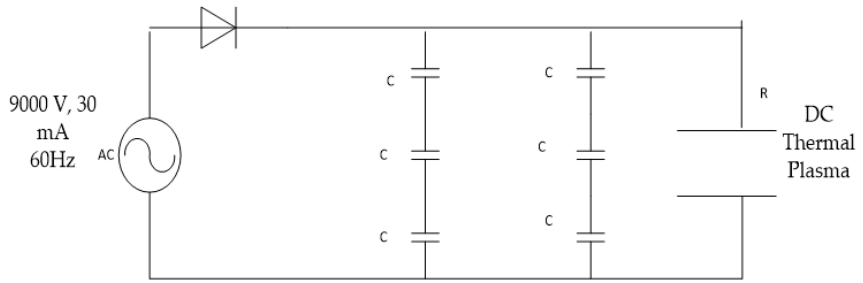
Figure 6. DC thermal plasma circuit.